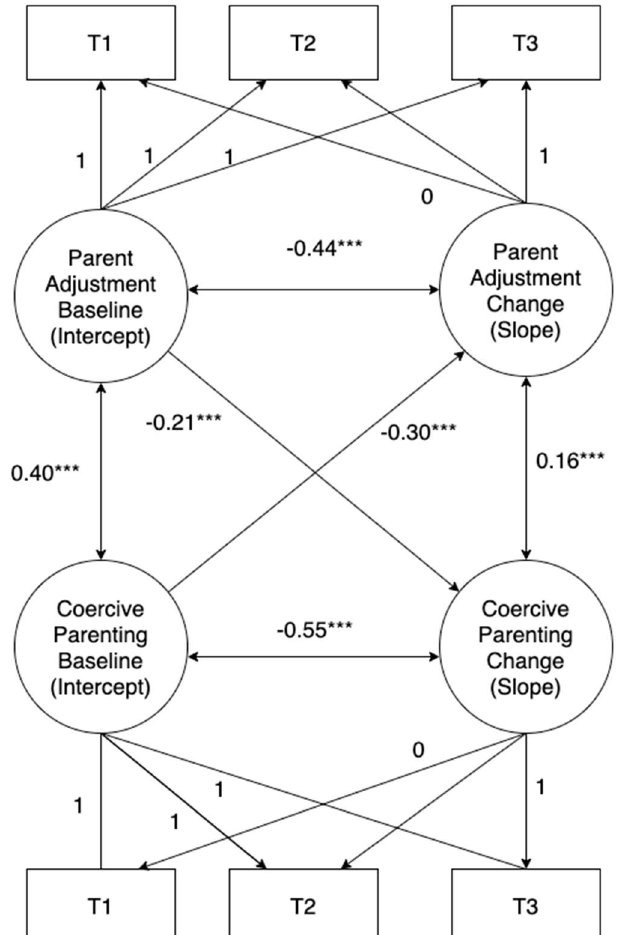
Figure 1. Latent growth Model of Intervention Outcomes. Note: *** p < 0.001. Table 3. Estimate, Standard error of Coefficient and p -values of slopes and intercepts association.